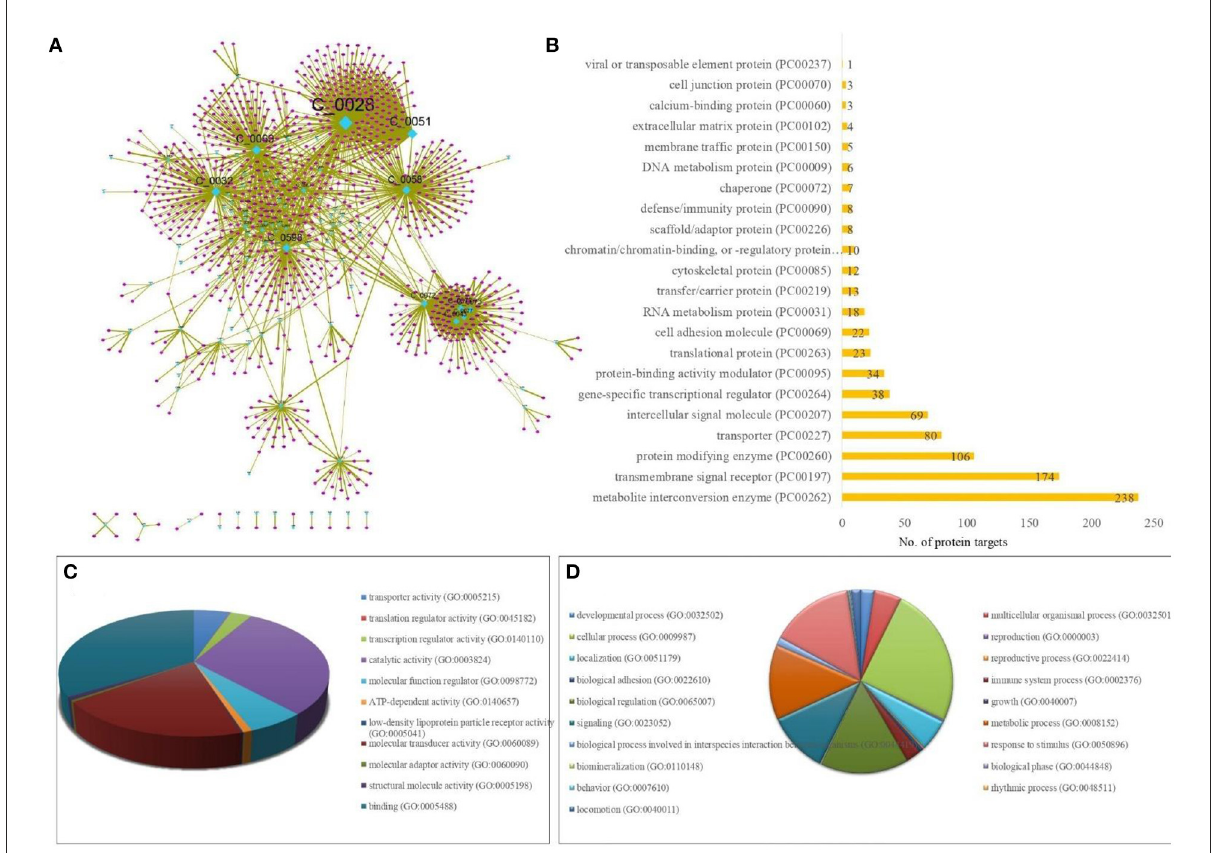
FIGURE4 Protein targets of TC specific to PACs (potentially active compounds of TC ). (A) Sub-network of size 1,100 nodes and 1,967 edges containing 95 PACs (cyan colored diamond nodes) and their 1,005 protein targets (pink colored circular nodes). The size of the nodes varies according to their degree value in the network, where the node with the highest degree is bigger in size corresponding to the other nodes. The protein targets were compiled from STITCH having interaction score ≥ 700. (B) Bar-graph showing the protein class association of the protein targets of PACs, highlighting the major contribution of the class of metabolite interconversion enzyme. X-axis represents the number of protein targets associated and the Y axis represents the protein-class. (C) GO-based molecular processes associated with protein targets of PACs with high enrichment among the class corresponding to “Binding (GO:0005488)” with involvement of 393 protein targets. (D) GO-based biological processes associated with protein targets of PACs with high enrichment among the class corresponding to “cellular process (GO:0009987)” with involvement of 641 protein